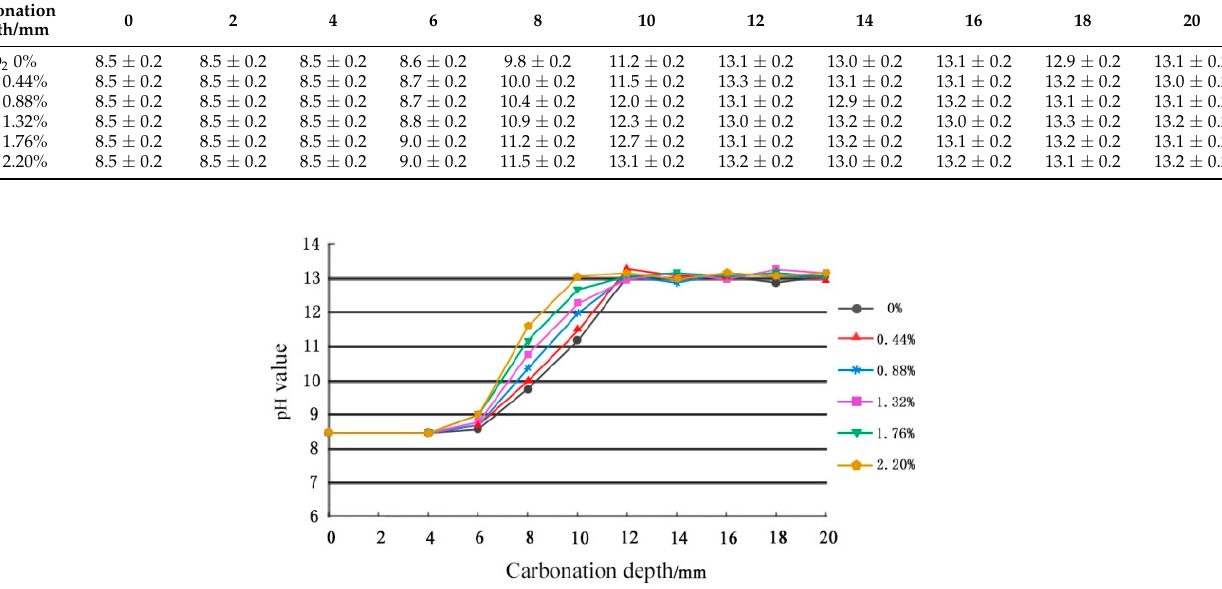
Figure 10. pH distribution of CO 2 ‐ absorbing cement mortar for 28 days (ultrasonic vibration